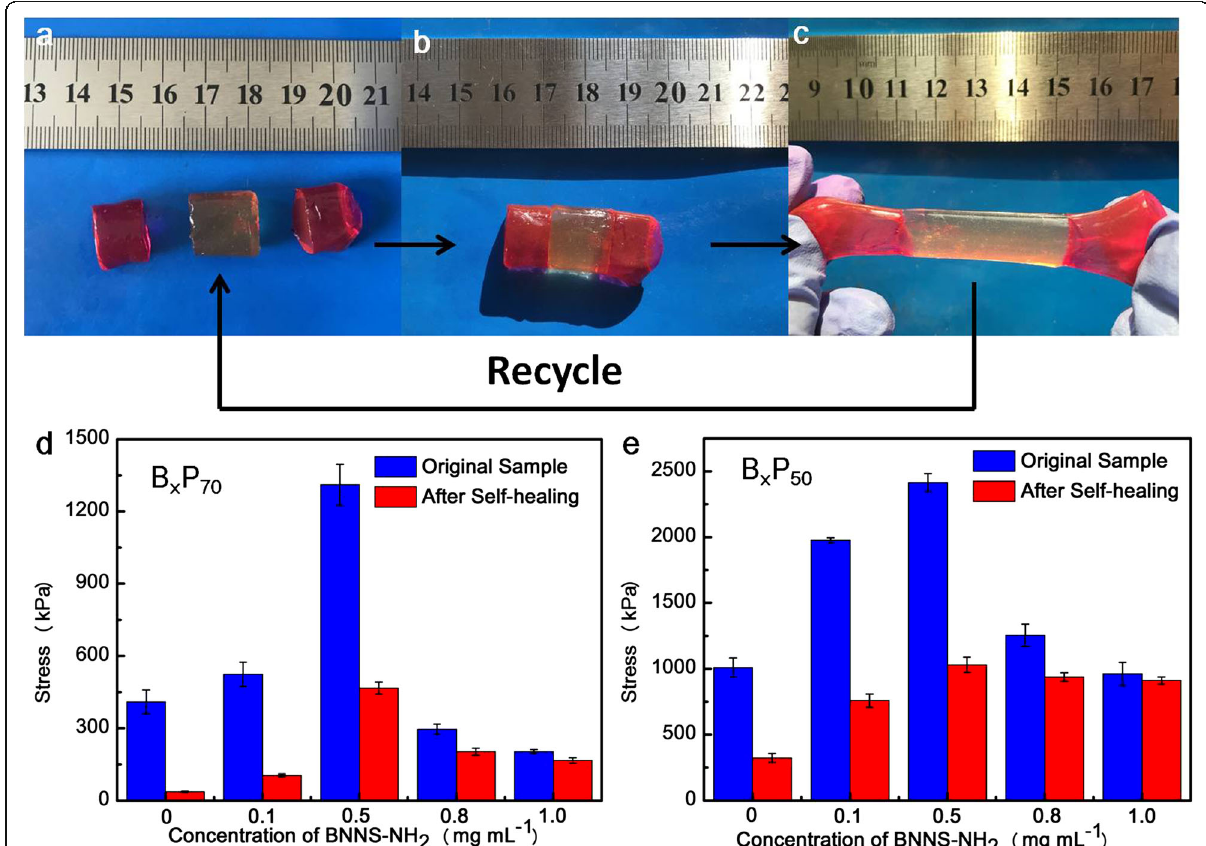
Fig. 7 Self-healing process of B 0.5 P 90 ( a ) the hydrogel was cut to three parts (the terminal two parts were dye to red by Rhodamine B). b Strictly put the three parts together one by one. c After 10min healing, the healed hydrogel can be stretched. d The fracture stresses of original B x P 70 and healed B x P 70 . e The fracture stresses of original B x P 50 and healed B x P 50. The healing time was